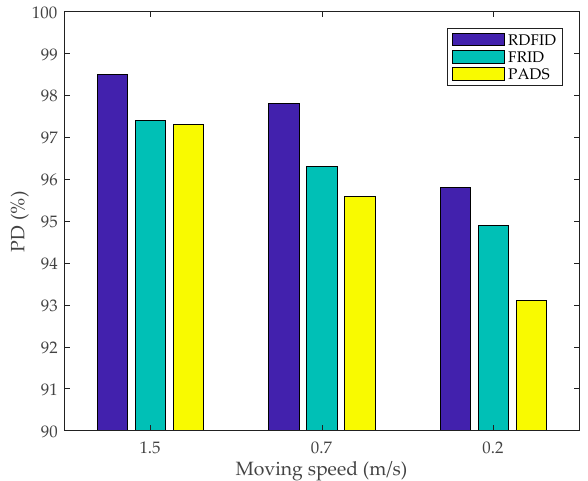
Figure 12. PD of human detection under different moving speeds.